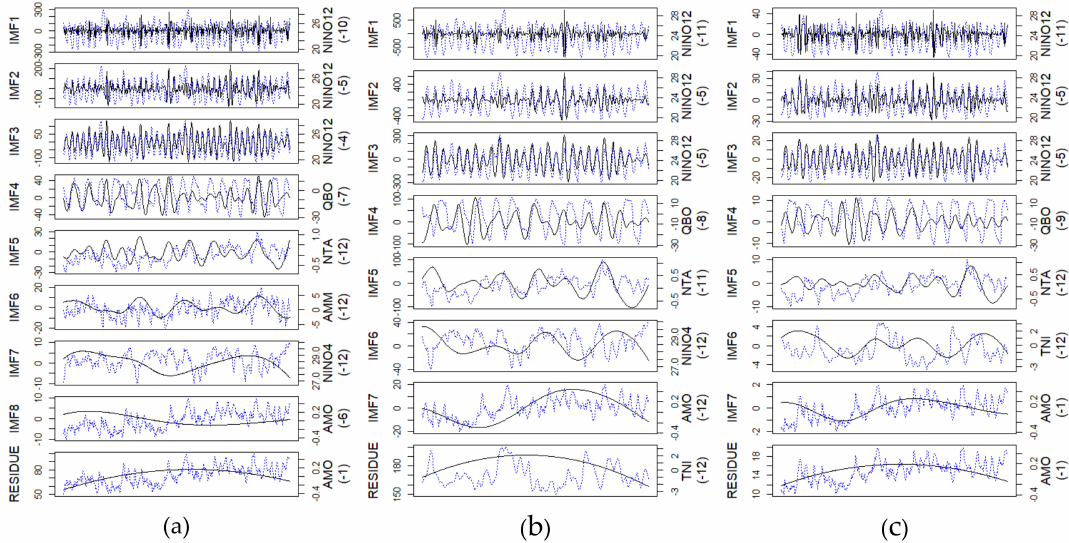
Figure 7. IMFs resulted from ensemble empirical mode decomposition (EEMD) (solid black line) and the lagged climate indices (blue dotted line) which have the highest correlation coefficient for each IMF.